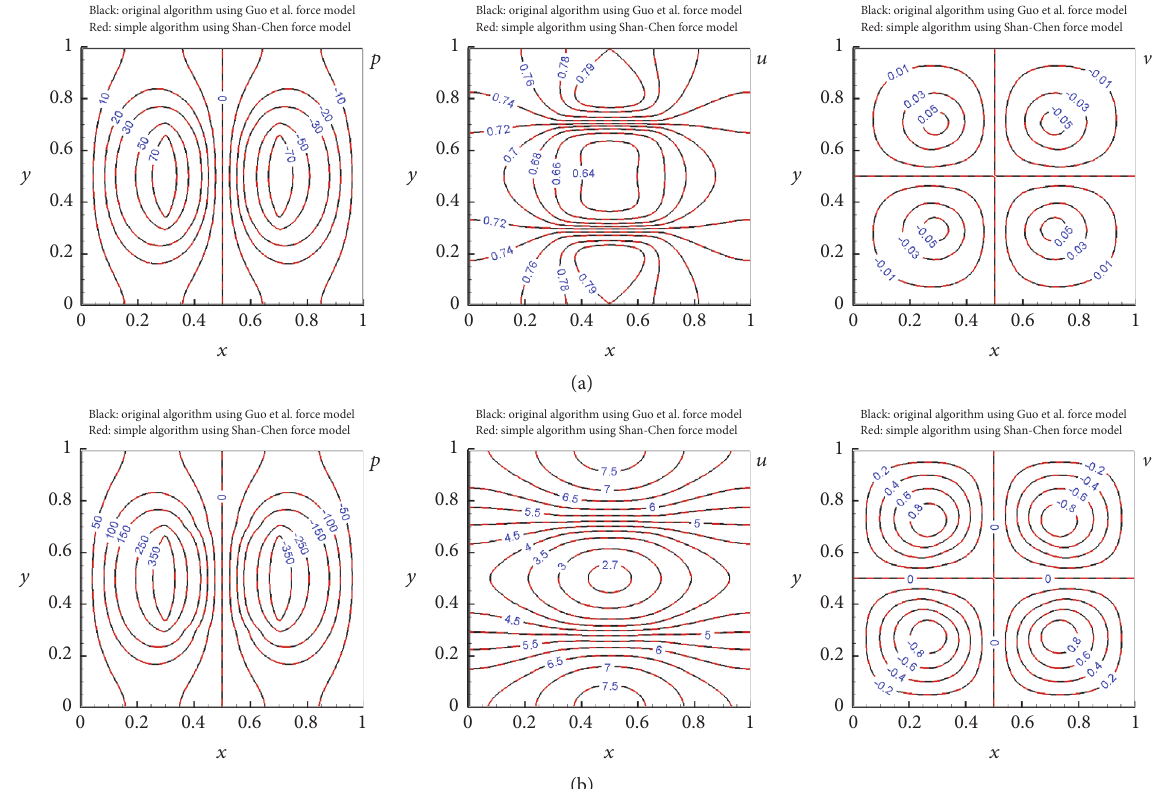
Figure 2: Comparisons of 𝑝 , 𝑢 , and V between two LBM simulations using different force models, transient results at 5000 th Δ𝑡 (a) and the steady state results (b), ] eff = 0.01 m 2 s −1 and